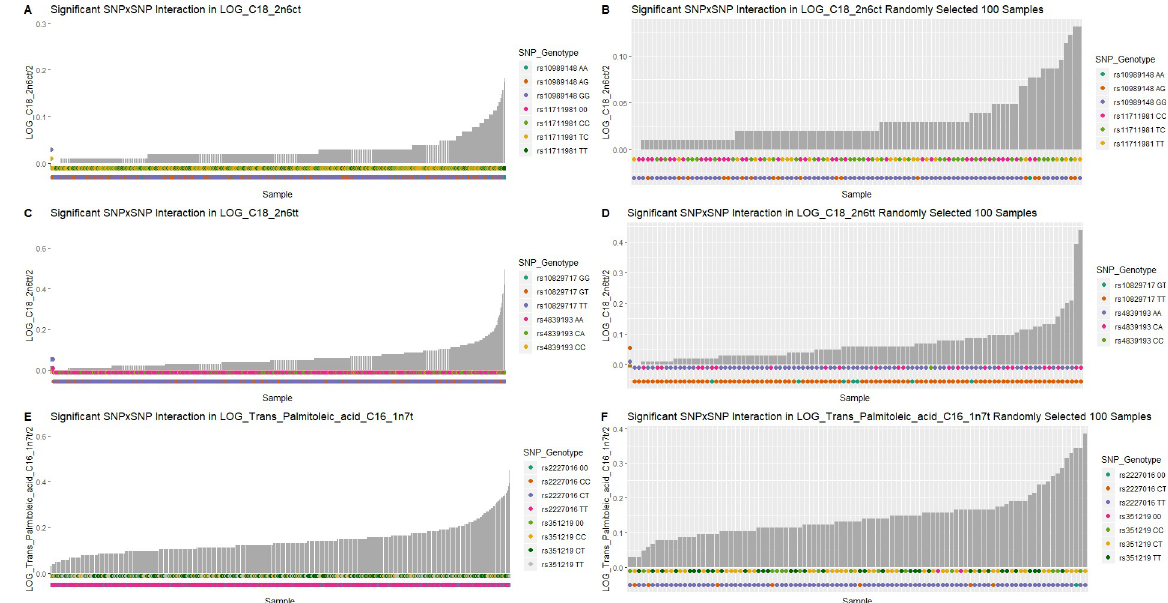
Fig 6. Distribution of phenotype and genotype for the top interactions in fatty acids under different filtering methods. The distribution of fatty acid concentration and corresponding SNP genotype for SNPs for the top interactions were plotted for A) rs10989148-rs11711981 in log- transformed 9-cis 12-trans octadecanoic acid under main effect filtering, C) rs10829717-rs4839193 in log-transformed 9-trans 12-trans octadecanoic acid under main effect filtering, and E) rs2227016-rs351219 in log-transformed trans palmitoleic acid (C16:1n7t) under main effect filtering. The randomly selected 100 individuals were also plotted for each top interaction (B, D, F). https://doi.org/10.1371/journal.pone.0238304.g006 “gene hubs”. Only the interactions in which both SNPs mapped to a gene (within a 5kb upstream/downstream gene boundary) were considered. Results that were mapped to a gene